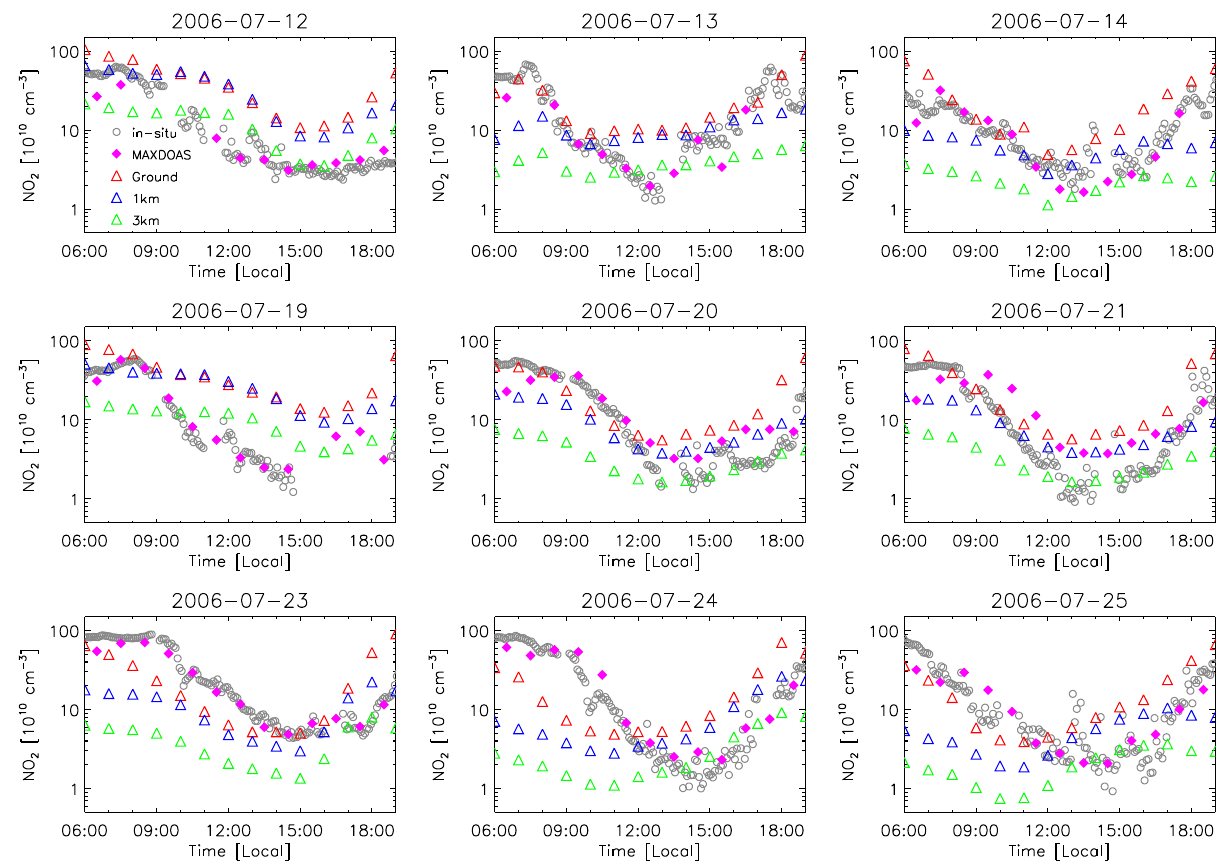
Fig. 10. Time series of NO 2 concentrations measured by MAX-DOAS (full pink diamond) and in-situ chemiluminescence instrument (open grey circle), and simulated by the CMAQ model on the 9 cloud-free days during the PRIDE-PRD2006 campaign. The “ground” (open red triangle), “1km” (blue triangle), and “3km” (open green triangle) represent the average NO 2 concentrations calculated by the CMAQ model in the layer of 0–18m, 0–1km, and 0–3km,